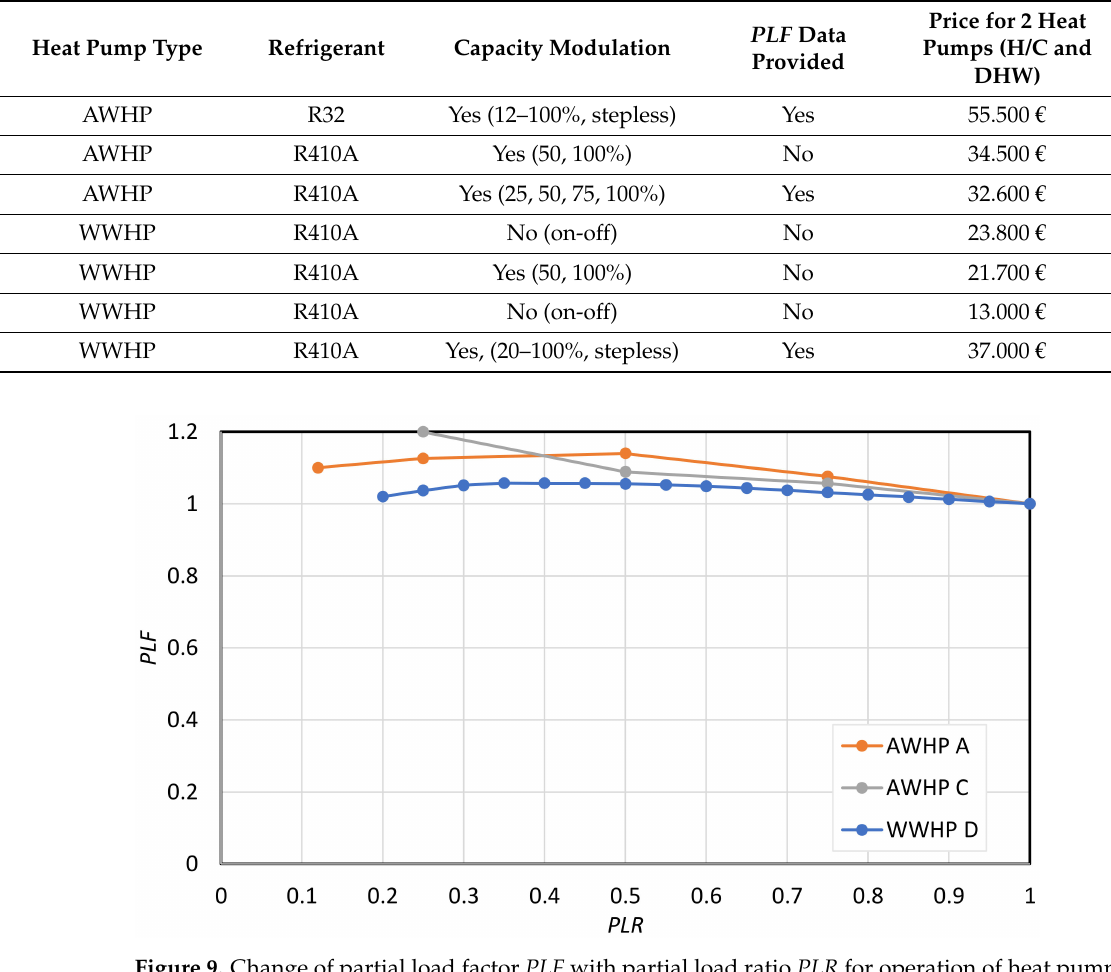
Figure 9. Change of partial load factor PLF with partial load ratio PLR for operation of heat pump in